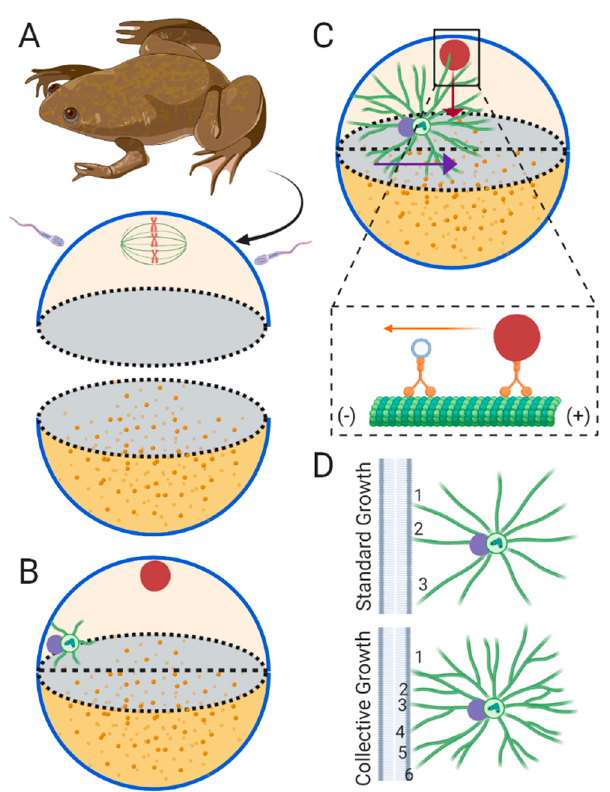
Figure 3. Fertilization and pronuclear migration in Xenopus. ( A ) The frog oocyte is arrested in metaphase II of meiosis. The meiotic spindle is located at the pole of the animal half of the egg (top beige hemisphere). The sperm can fertilize the egg along the side of the animal half. The yolky vegetal half is illustrated as the lower dark yellow hemisphere. ( B ) Fertilization resumes the cell cycle, resulting in formation of the female pronucleus (red circle) near the animal pole after meiosis completes. The paternally derived centrosomes begin forming the interphase sperm aster attached to the male pronucleus (purple circle). ( C ) The sperm aster expands and migrates toward the center of the egg, just above the vegetal half. As the astral MTs contact the female pronucleus it is transported retrograde along astral MTs in a dynein dependent manner (inset). Furthermore, cytoplasmic dynein / cargo (inset) likely generates pulling forces through retrograde transport. ( D ) Simplification of sperm aster growth according the standard growth model (top) and the collective growth model (bottom). The standard growth model predicts that asters are formed solely from centrosome-nucleated MTs, while the collective growth model includes MT-dependent MT nucleation, or MT branching. When considering pushing forces due to MT polymerization against the cell cortex, long individual MTs (numbered 1–3) nucleate from the centrosome and bear a high compression load, which can lead to MT buckling and decentering (see text for details). However, this problem is solved by the collective growth model in which the compression load is redistributed to a greater number of short MTs (numbered 1–6) polymerizing against the cortex .